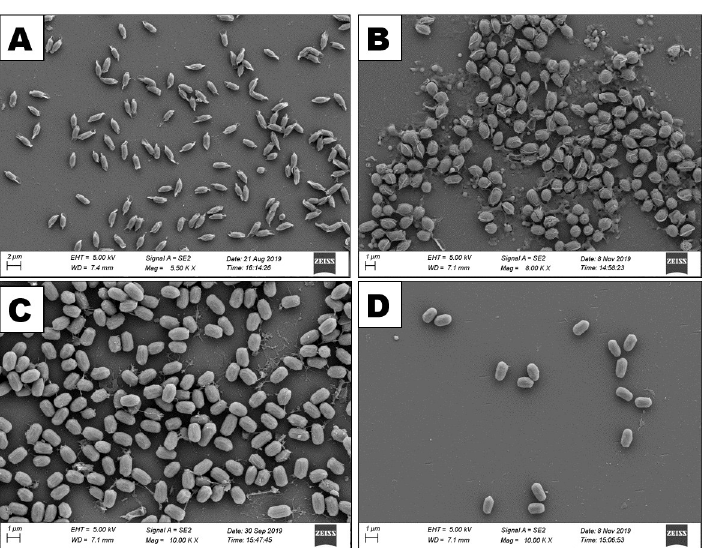
Fig 12. Scanning electron micrograph showing vegetative bodies of the bacterial isolates. A: Bacillus cereus HABW1, B: Bacillus megaterium HABW4, C: Bacillus subtilis HABW10, D: Bacillus tequilensis HABW14.